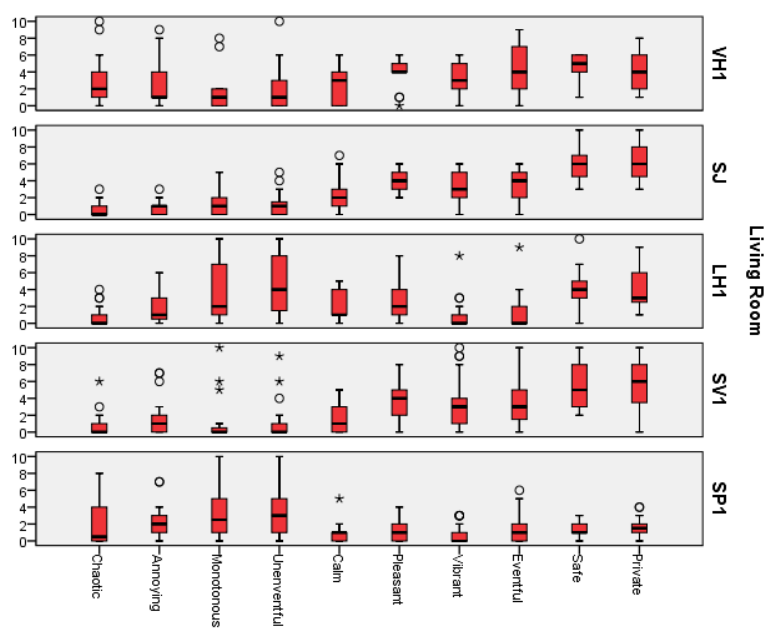
Figure 15. Distributions of Q4 scores for its ten items, sorted by living room. Table 3. Test statistic values and asymptotic significance (2-sided test).